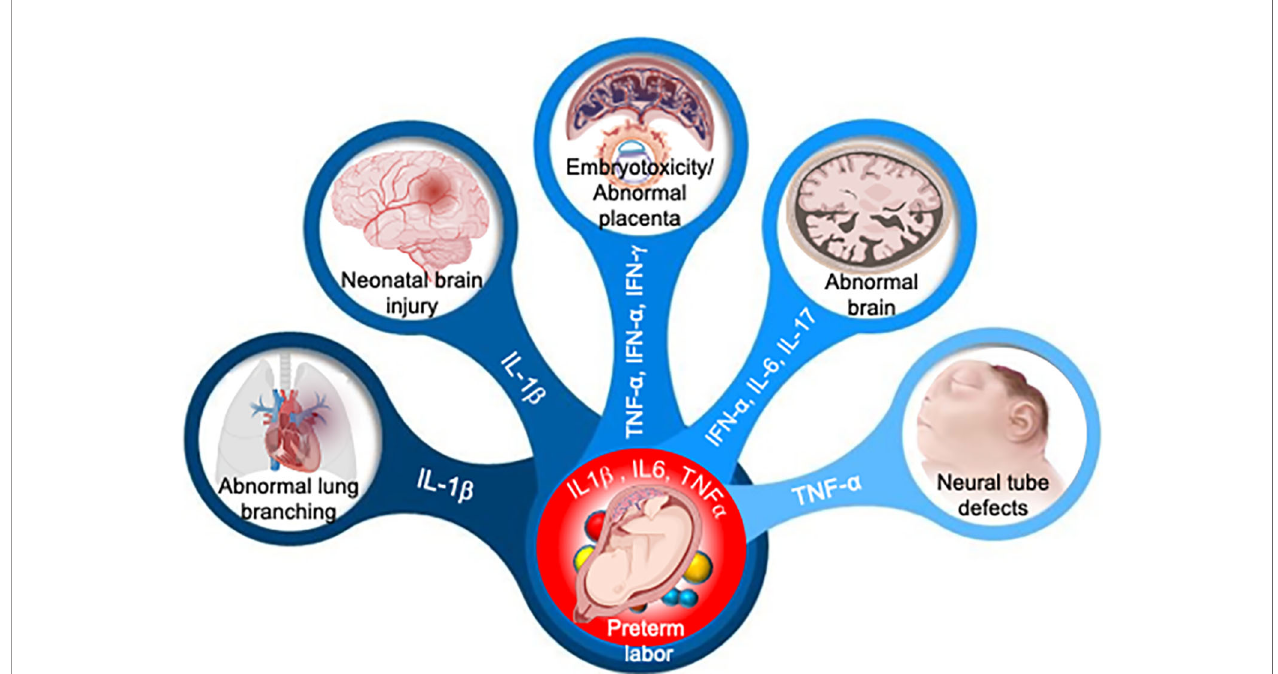
FIGURE 3 | Adverse pregnancy outcomes induced by aberrant cytokine response. Aberrant levels of IL-1 b , IL-6, IL-17, TNF- a , IFN- a and IFN- g in amniotic fl uid can induce multiple organ development failure in fetus or induce premature activation of cervical ripening proteins and onset of preterm labor.